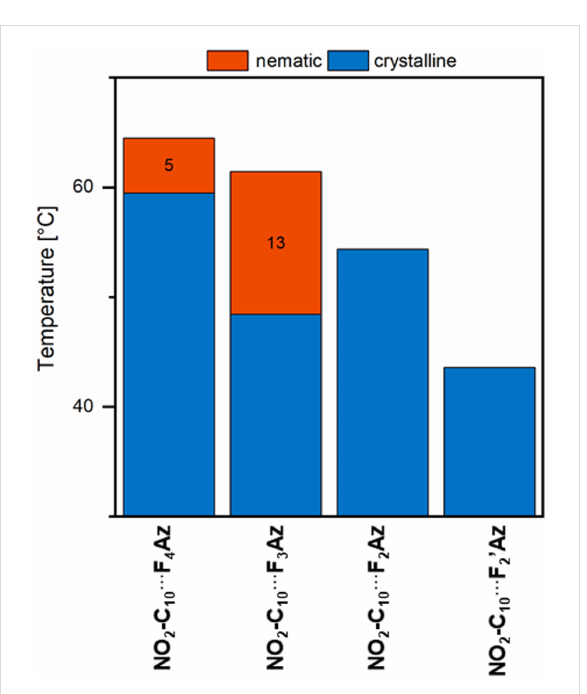
Figure 5: Summary of the thermal behaviour of the azo complexes with decreasing fluorination degree as observed by DSC upon cooling from the isotropic melt. Mesophase ranges are given in black